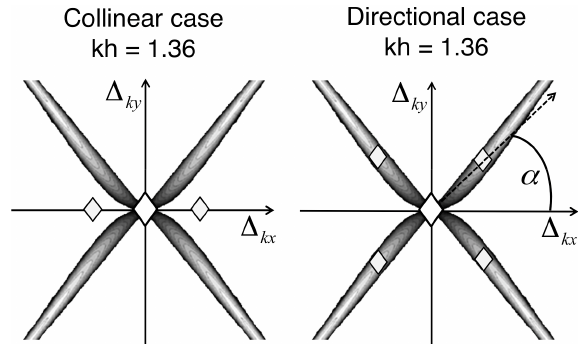
Fig. 1. Instability region and location of side bands for kh → ∞ : collinear disturbances (left panel); oblique disturbances (right panel).